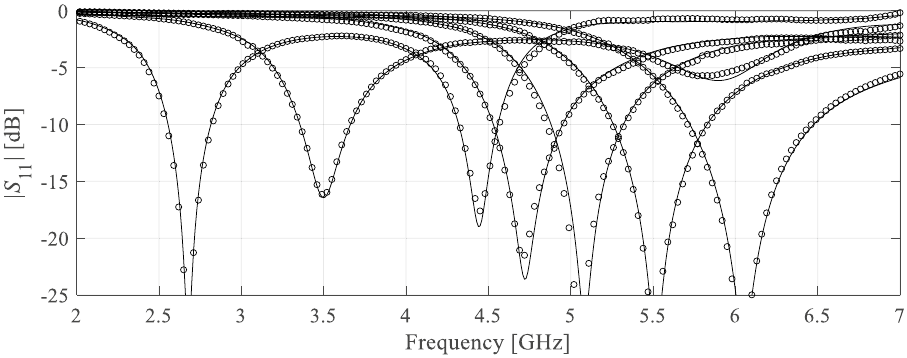
Figure 12. Antenna I: reflection responses at the representative test designs: full-wave model (—), and the presented two-level variable-fidelity surrogate (o) with N Bf = 50 and N Bc = 800.